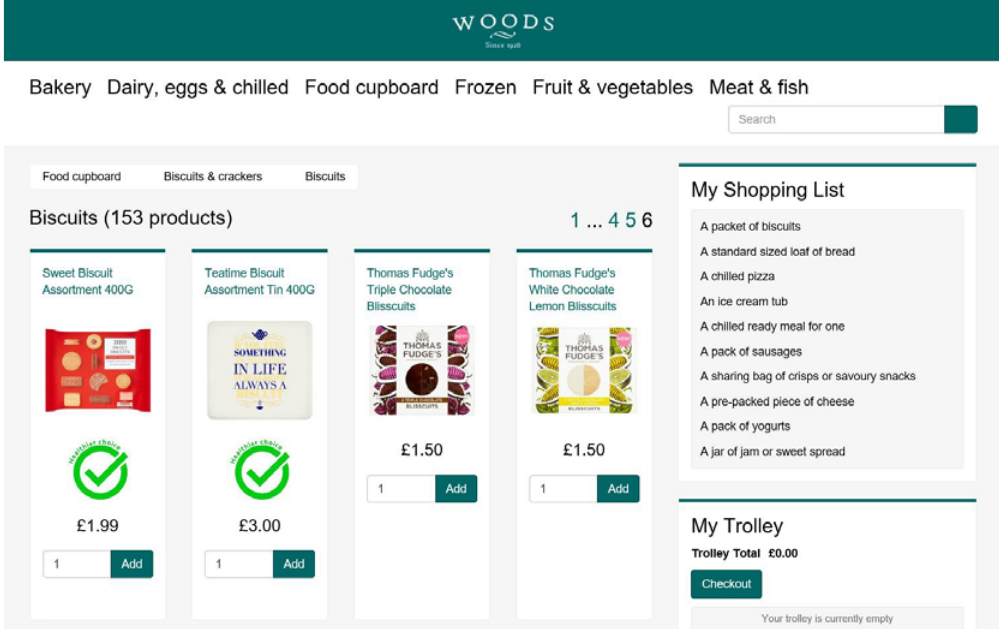
Figure 1. An example of a page of the online supermarket where “healthier choice” badges were displayed.